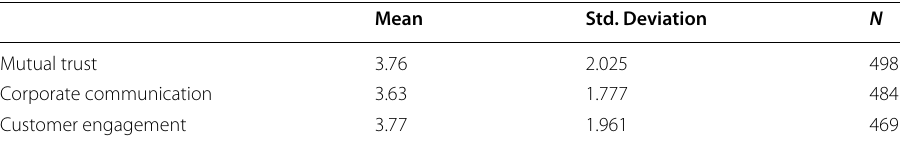
Customer engagement Mutual